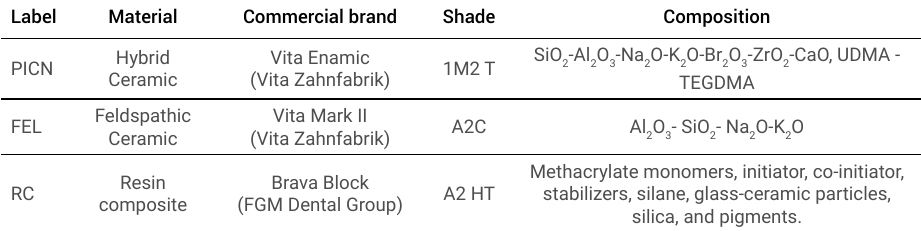
Table 1. Labels, material type, commercial brand, shades, and composition of each CAD/CAM material used in the study.